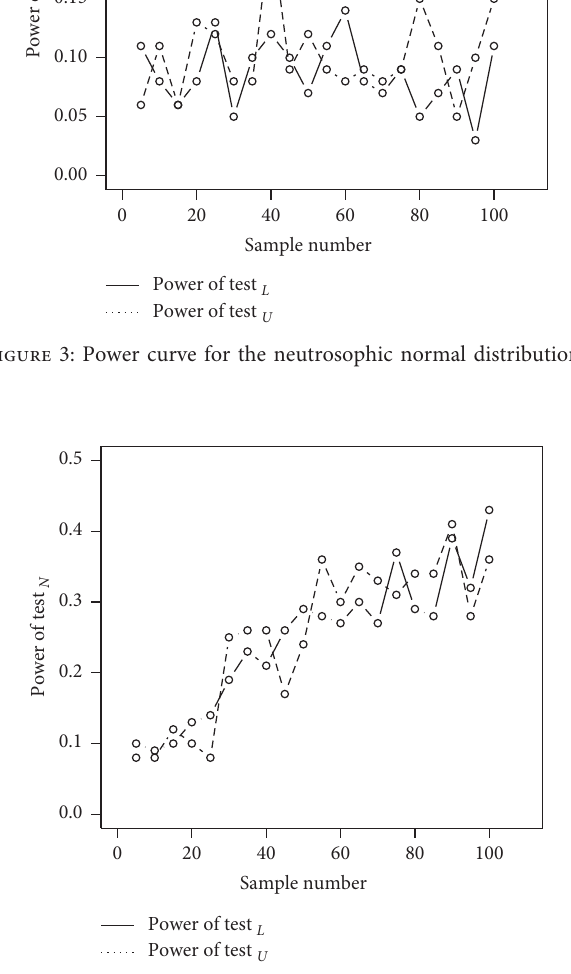
Figure 4: Power curve for the neutrosophic t